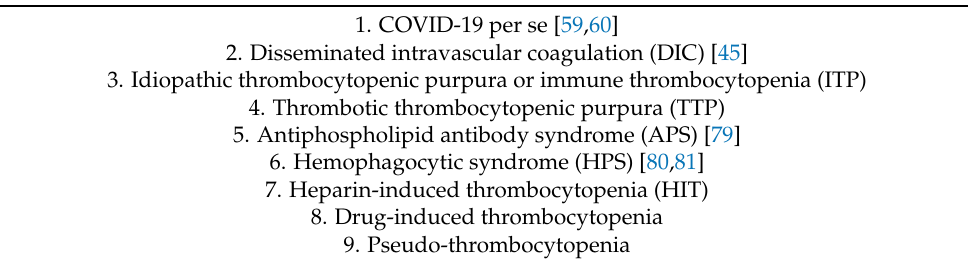
Table 1. Causes of thrombocytopenia in